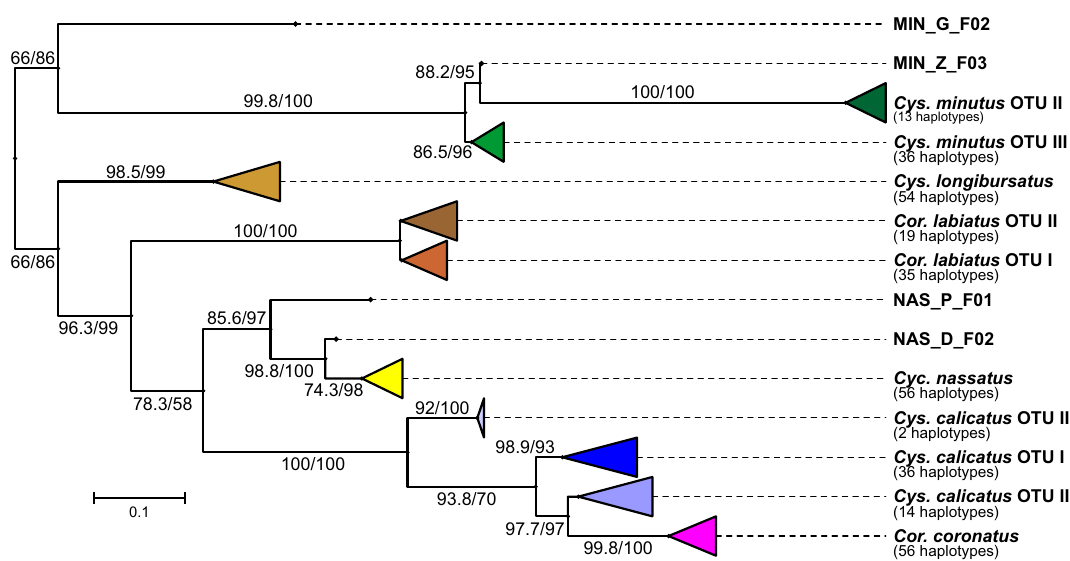
Figure 3. Maximum likelihood phylogenetic condensed tree calculated using aligned concatenated internal transcribed spacer 2 and cytochrome oxidase I sequences. The scale bar represents 0.1 substitutions per site and node support was obtained by ultrafast bootstrapping (1000 replicates) after and the Shimodaira-Hasegawa likelihood ratio test before the slash. Individual specimens that were not assigned to one of the major clades are designated according to the following code: MIN and NAS for the species Cylicostephanus minutus and Cylicocyclus nassatus , respectively; G, H, P, K, D, Z for the hosts German horse, Ukrainian horse, Przewalski’s horse, kulan, donkey and zebra, respectively; F/M for female or male; a number indicating the individual specimen. OTU, operational taxonomic